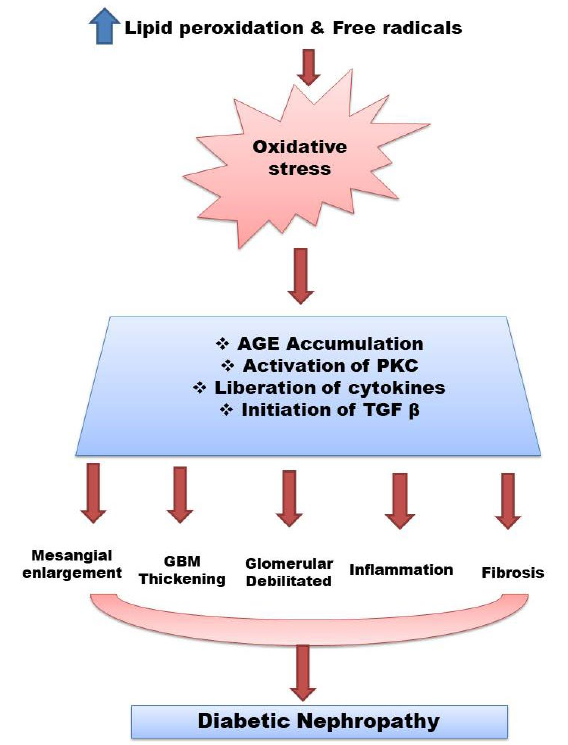
Figure 1. Pathophysiology of diabetes nephropathy. Abbreviations: Advanced glycosylated end products (AGEs), glomerular basement membrane (GBM), protein kinase C (PKC), transforming growth factor beta(TGF- β ).